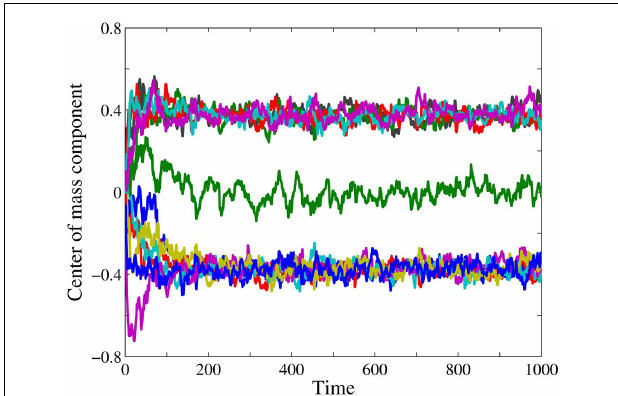
FIGURE 2 | Real time pattern identification .Time series of the components of the center of mass vector R given by equation (3), here on the base graph G ( 2 ) 12 for a window [ t L , t U ] = [1,10] and influx probability p = 0.074. Every color corresponds to one component of the center of mass vector.We start from an empty base graph, which is gradually occupied. A stationary state has evolved after about 200 time steps.The trajectory of R 2 (green) fluctuates around zero.The corresponding bit position is non-determinant, see text.The trajectories of the five components R 7 , R 9 , R 10 , R 11 , R 12 fluctuate around 0.4 and those of the 6 components R 1 , R 3 , R 4 , R 5 , R 6 , R 8 around − 0.4,The corresponding bit positions are determinant.Together there are 11 determinant bits,